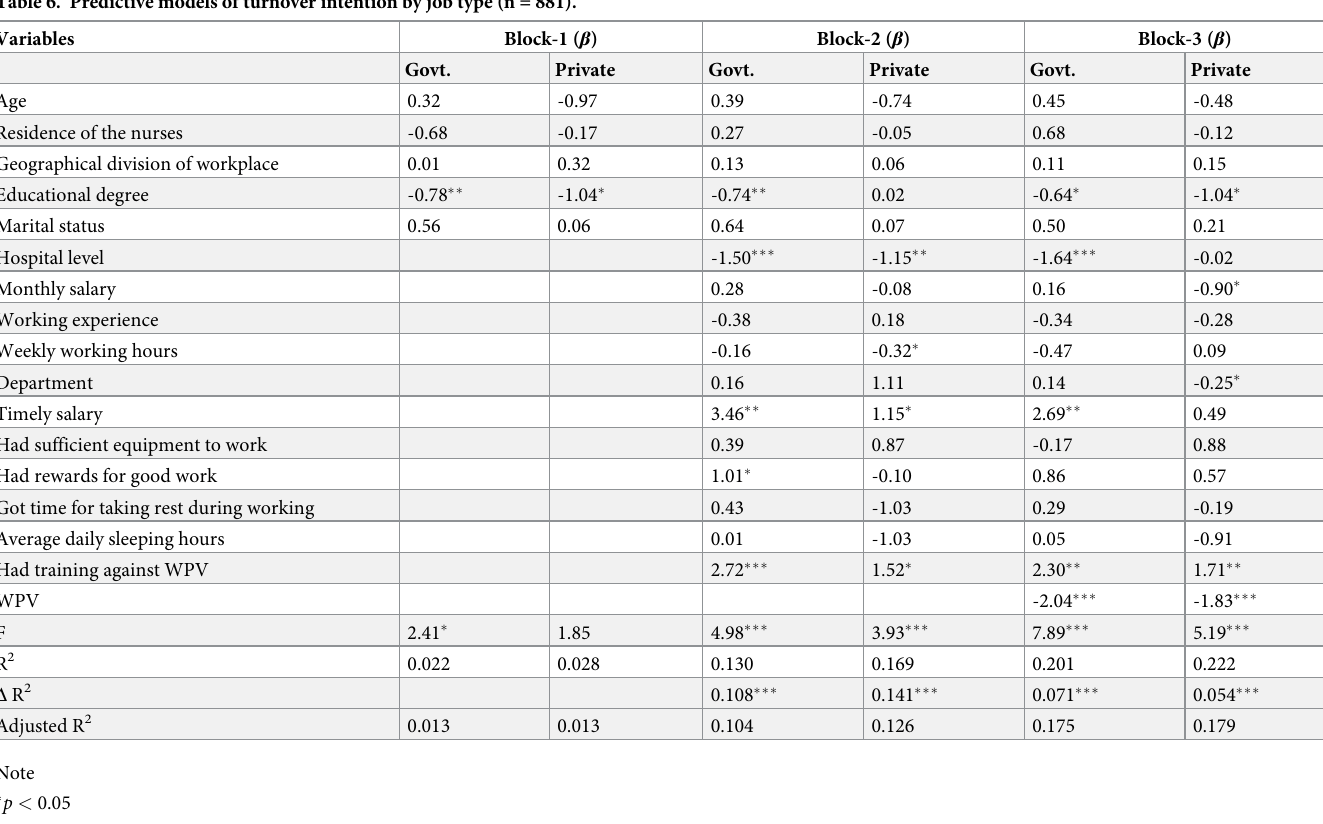
Table 6. Predictive models of turnover intention by job type (n =